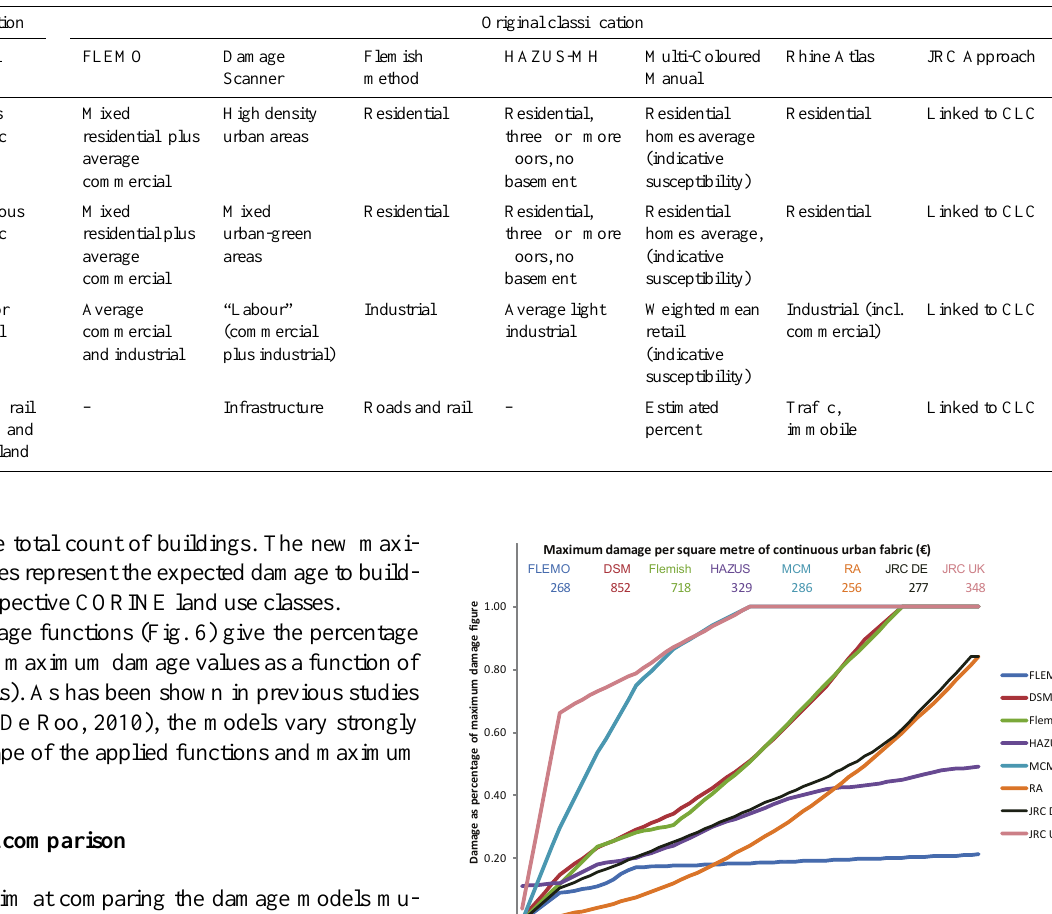
Table 1. Reclassification of the original categories of the damage models to the four CORINE land use classes applied in this study. Selection of a specific damage category is done manually, whereby the median category is chosen in case of multiple possibilities.